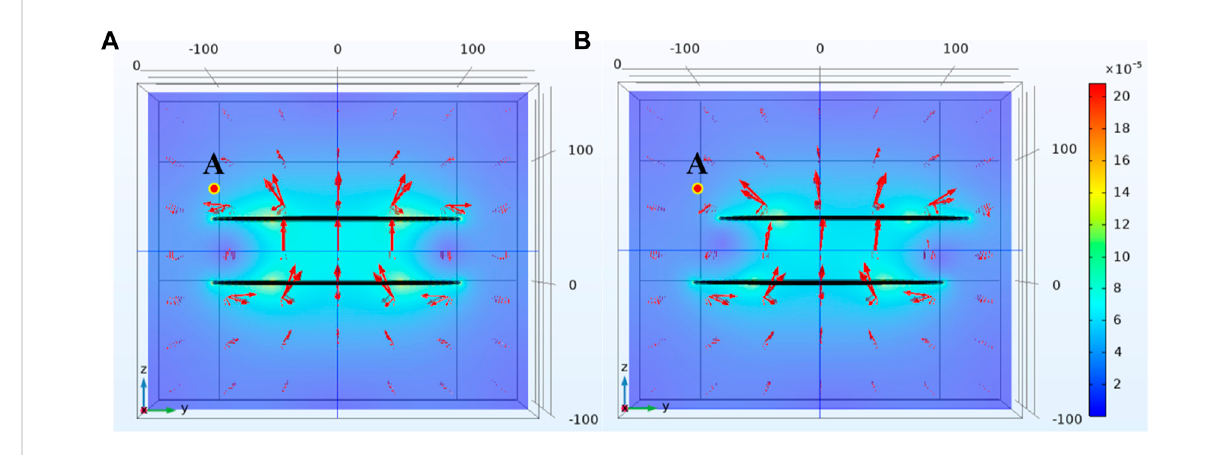
FIGURE 10 The magnetic fi eld simulation results. (A) The alignment situation. (B) The offset situation.